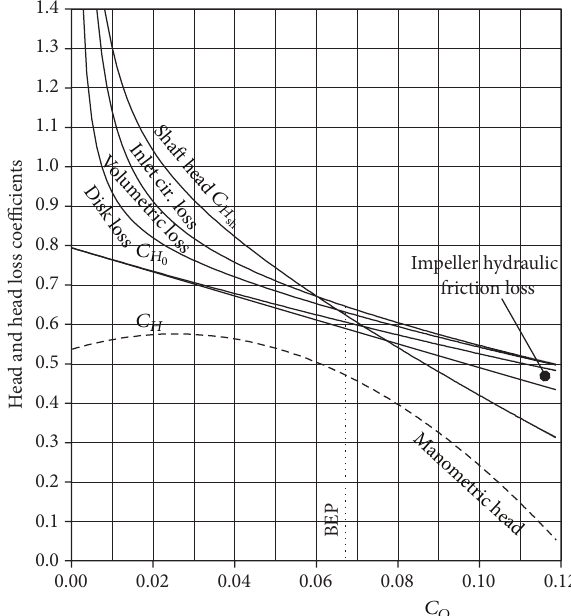
Figure 14: Head loss coefficients affecting pump power at different discharge coefficients.